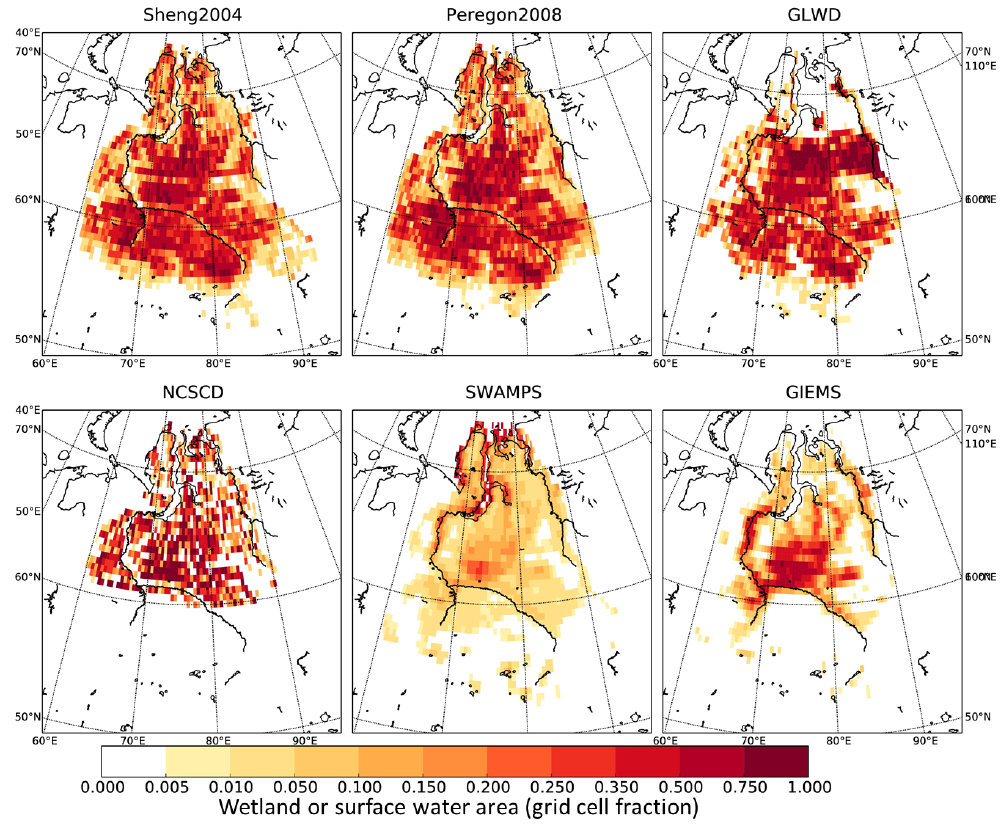
Figure 3. Observational data sets related to wetland areas. For SWAMPS and GIEMS, areas shown are the June–July–August (JJA) average surface water area fraction over the period